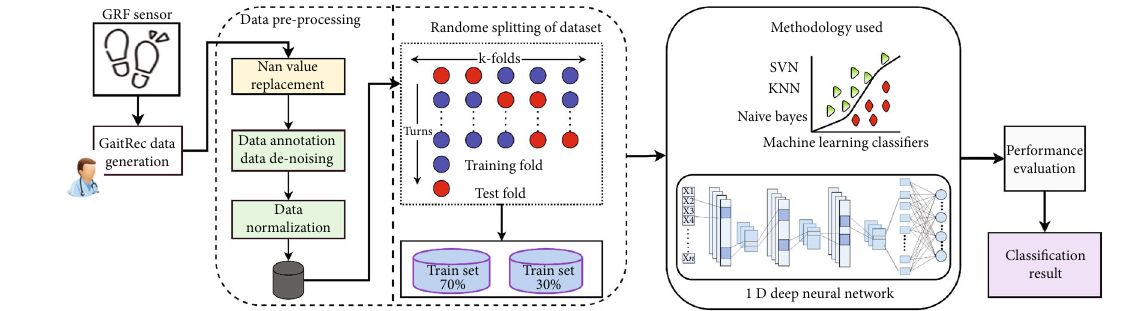
Figure 1: Block diagram of the proposed system. Table 1: Represent a total number of data in the GaitRec dataset.